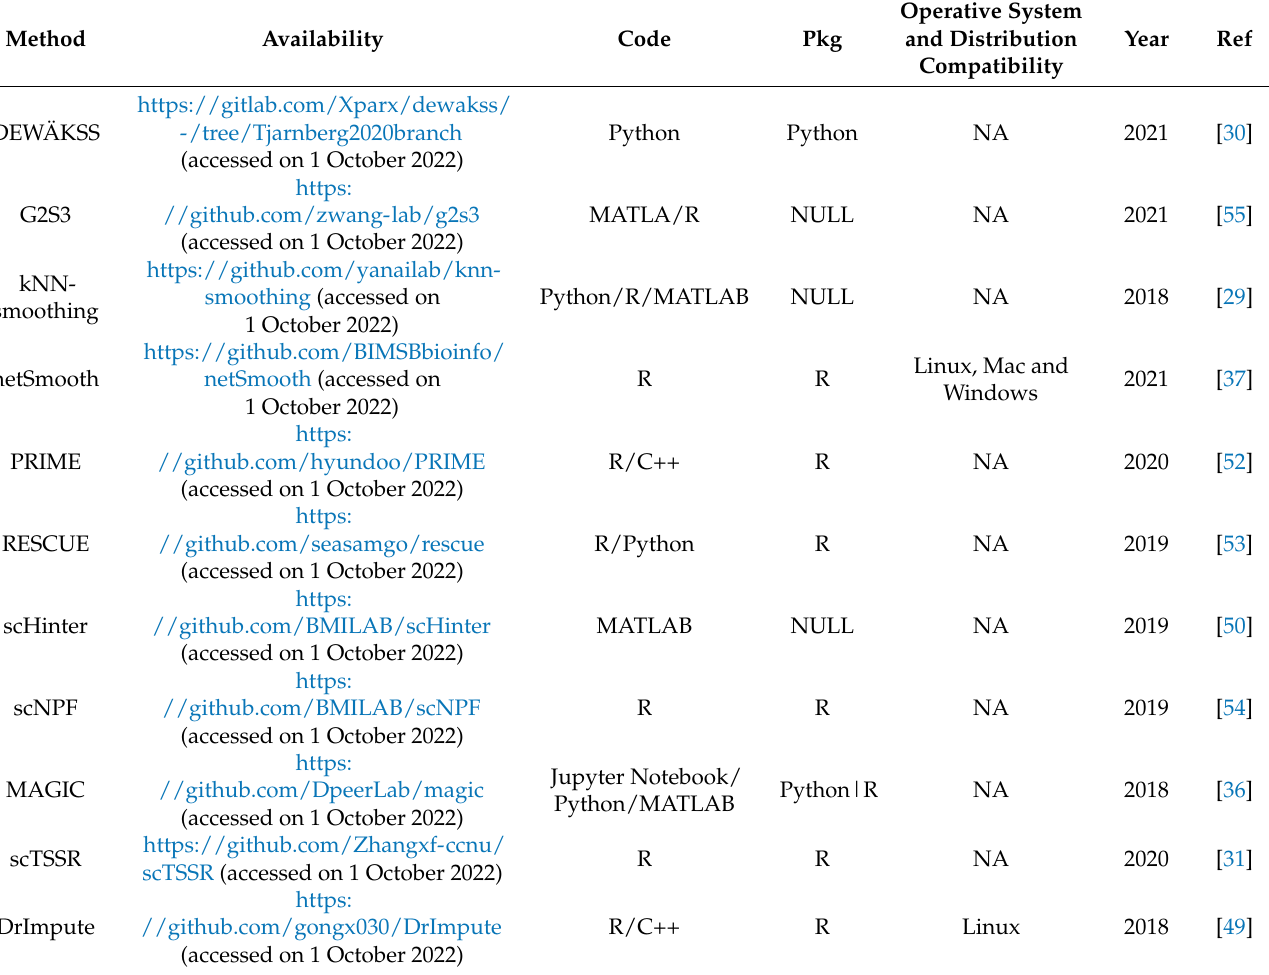
Table 4. The availability links, programming language, whether a package is available, year of presentation, operative system, distribution compatibility and reference of the representative methods based on